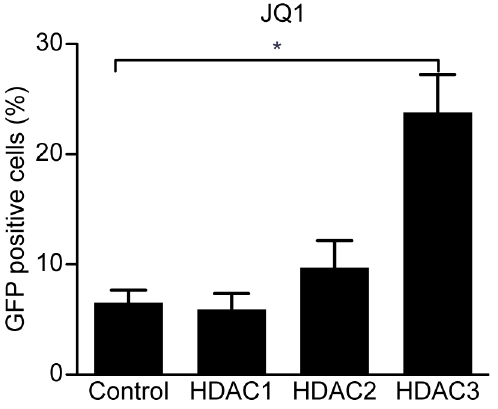
Figure 5. JQ1 enhances the effects of HDAC3 depletion. A significant increase in GFP protein expression from the HIV-1 promoter was observed in 2D10 cells that had been depleted of HDAC3 and had been treated with JQ1 (50 nM) for 24 hours over cells that were transduced with the scrambled shRNA control and treated with JQ1. However, no effect was observed in cells depleted of HDAC1 or HDAC2. (*p , 0.05).